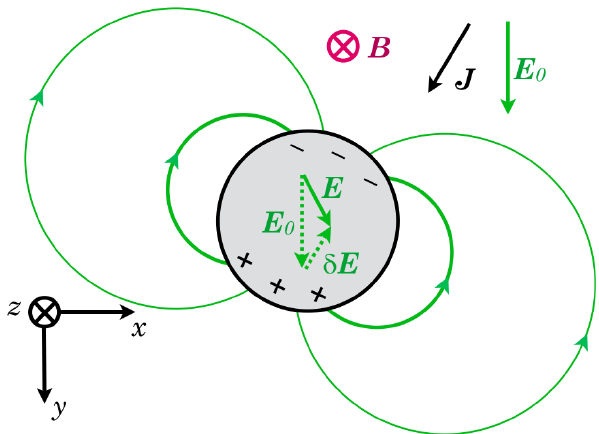
Figure 4. The Hall current, not yet shown in Fig. 2, adds a rotation to the polarisation of the patch; however the exact solution for a sharp circular boundary is still a cylindrical